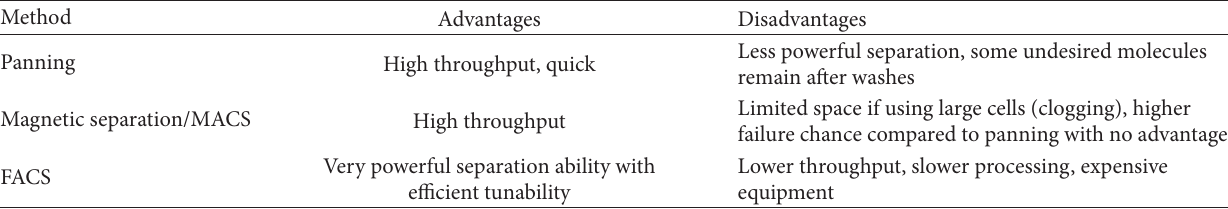
Table 3: Library screening methods for cell